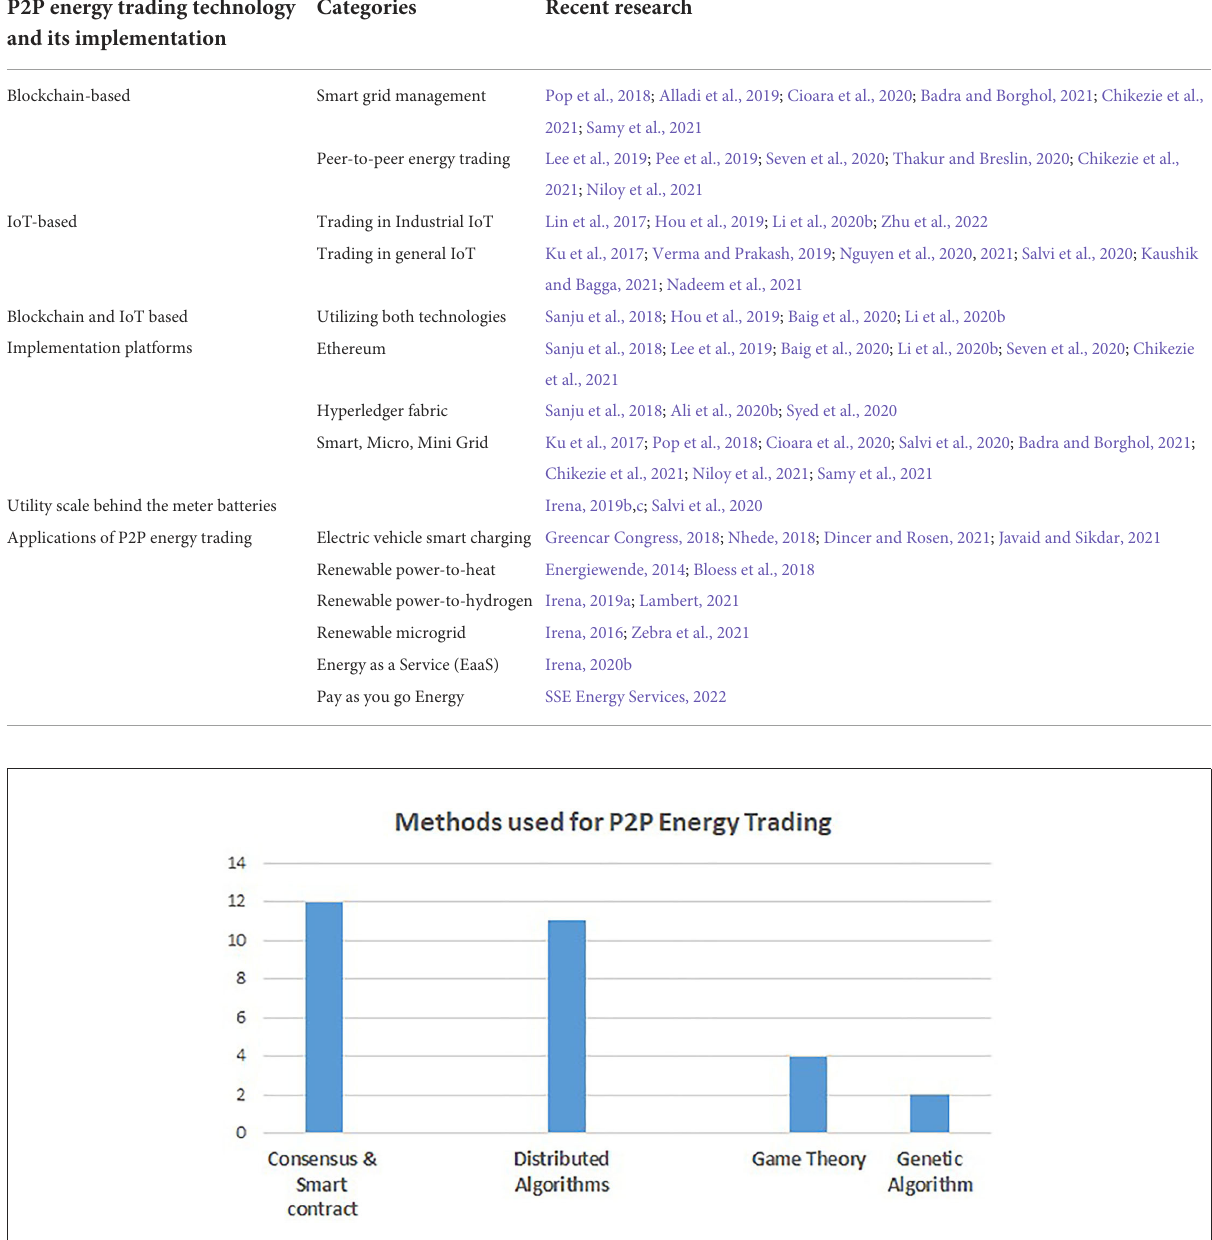
TABLE 1 Summary and analysis of energy trading enabling technologies.